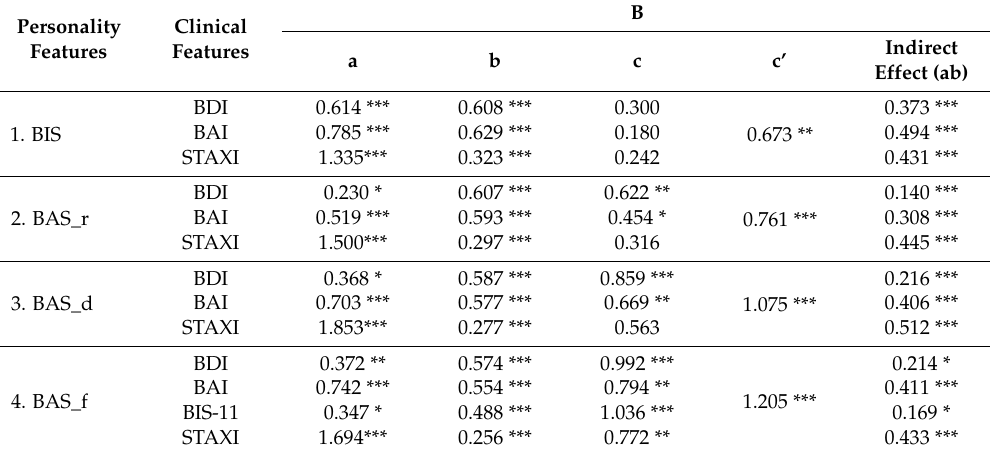
table and figure. BIS = Behavioral Inhibition System scale; BAS_r = Behavioral Activation System scale_Reward responsiveness; BAS_d = Behavioral Activation System scale_Drive; BAS_f = Behavioral Activation System scale_Fun seeking; BDI = Beck Depression Inventory; BAI = Beck Anxiety Inventory; BIS-11 = Barratt Impulsiveness Scale; and STAXI = State-Trait Anger Expression